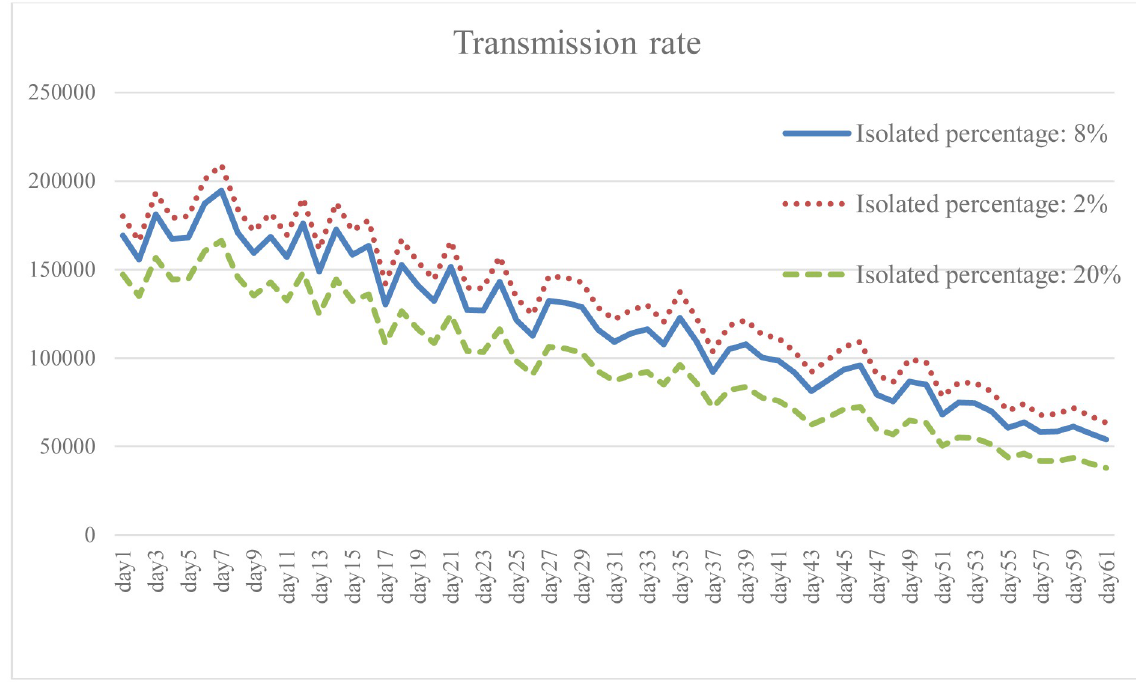
Fig 7. Transmission rate under different isolation